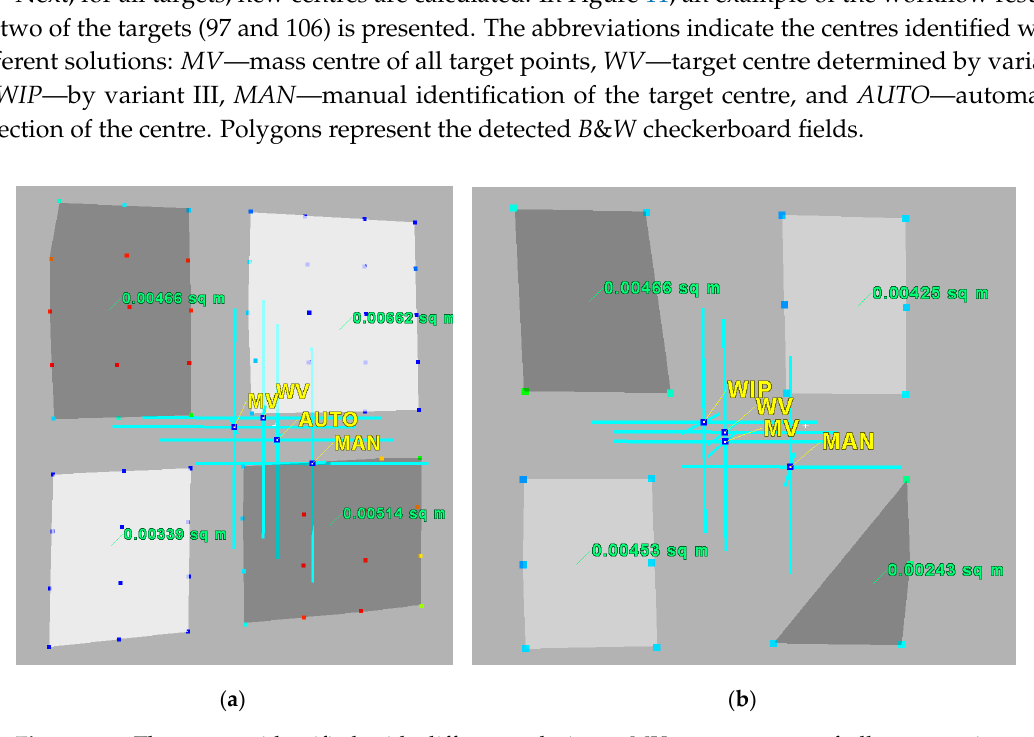
Figure 11. The centres identified with different solutions: MV —mass centre of all target points, WV —target centre determined by the variant II approach, WIP —variant III, MAN —manual identification of the target centre, and AUTO —automatic. ( a ) Target 97 (regular, good quality), ( b ) target 106 (incomplete, irregular).